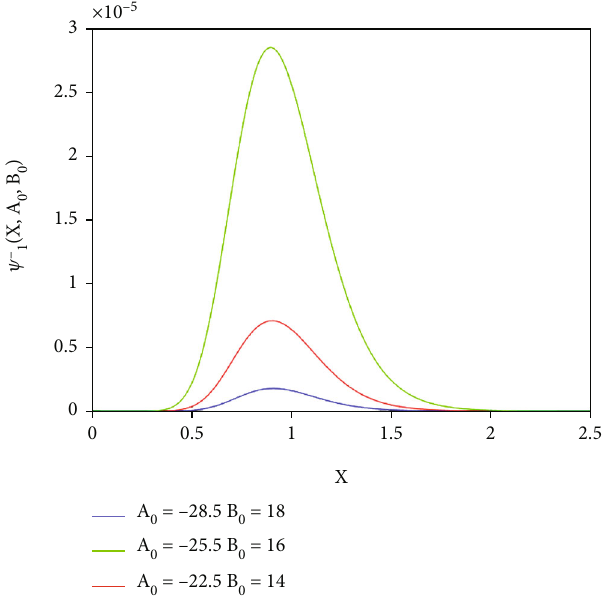
ð x , A Þ ( m = 2, n = 3, p = 0 : 5 ). , B 0 0 0